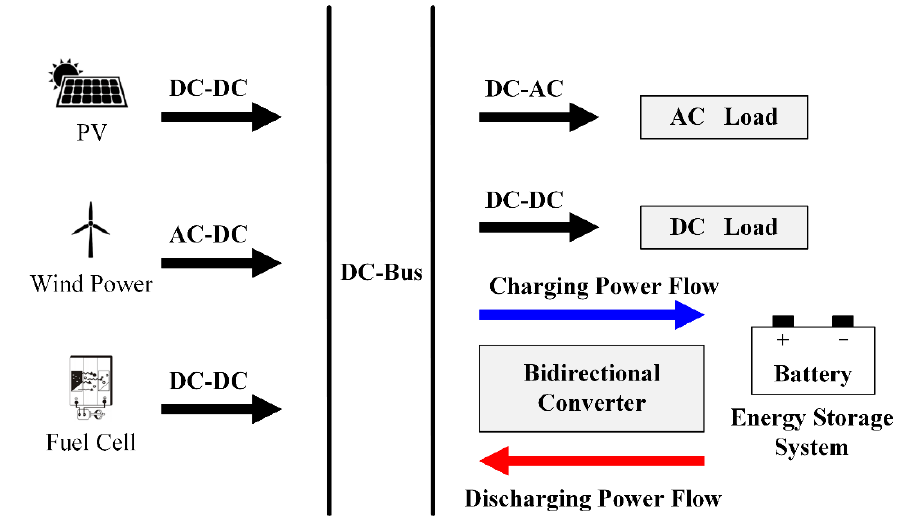
Figure 1. A backup battery in interfacing with various power supplies.